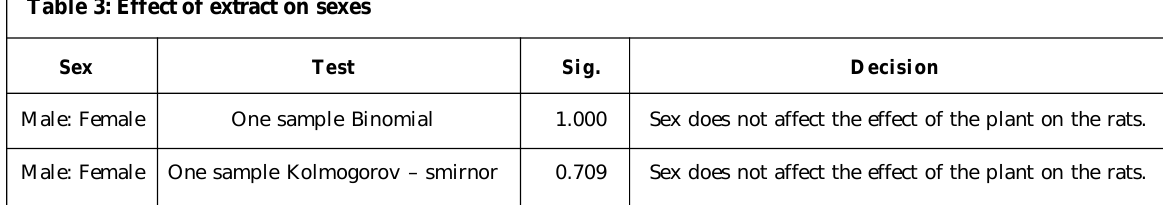
Table 3: Effect of extract on sexes